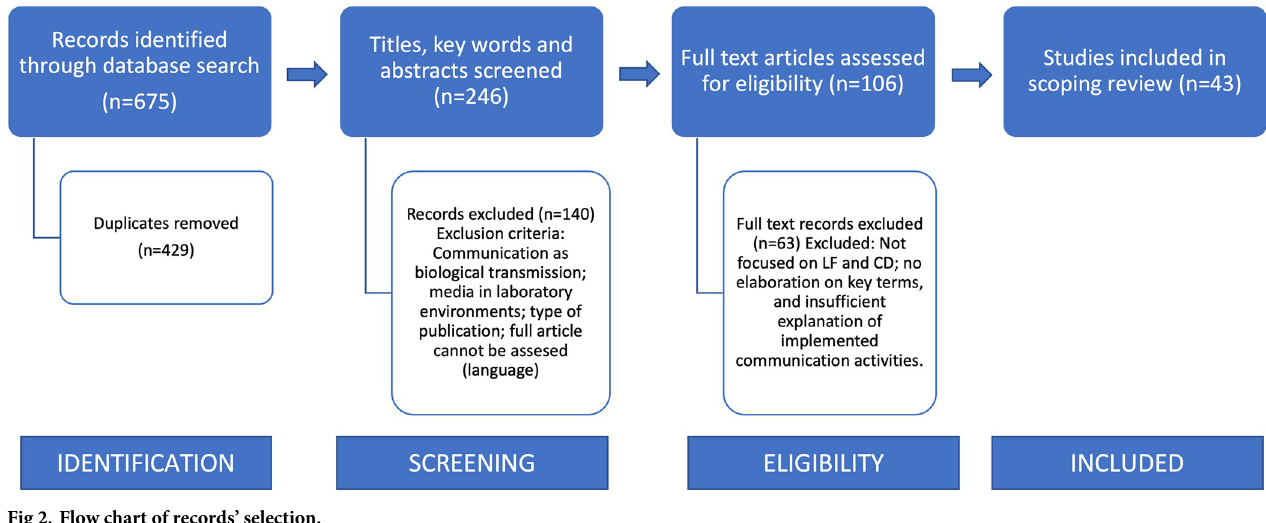
Fig 2. Flow chart of records’